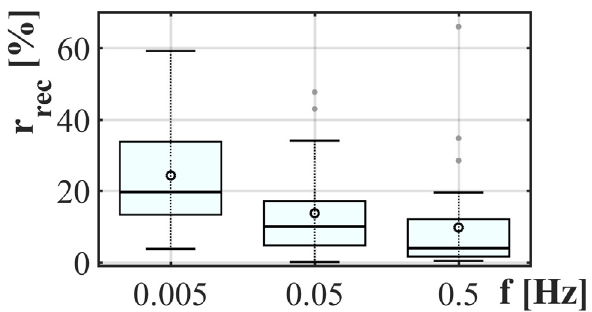
Fig. 3 | Boxplots reflecting the percentage of rectification of the current, i , normed with the average rectified value of a sinusoidal signal ( r rec , equation (7)). The boxplots are based on the evaluation of all subjects (N=28). These results are obtained from the recordings with different voltage frequencies (0.005 Hz, 0.05 Hz, and 0.5 Hz) and always shown for the first period (out of two). The horizontal line in the middle of each boxplot denotes the median; the circle indicates the mean value; and the whiskers indicate the 5% and 95% percentiles. The upper percentile is below 20% at 0.5 Hz which is in accordance with the observation that most subjects exhibited non-rectified currents at this